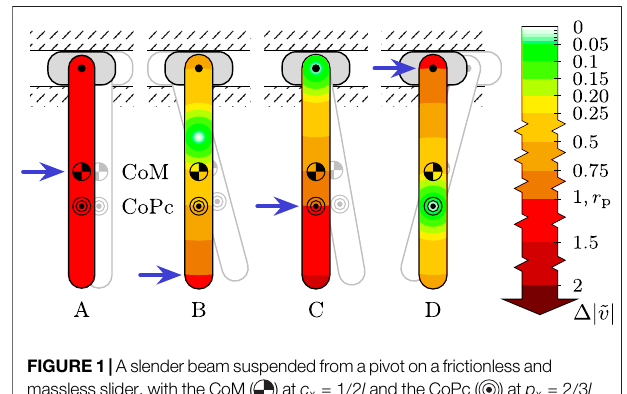
FIGURE1| Aslenderbeamsuspendedfromapivotonafrictionlessand massless slider, with the CoM ( ) at c x (cid:2) 1 / 2 l and the CoPc ( ) at p x (cid:2) 2 / 3 l from the pivot point. The initial response is shown in gray: if struck by an impactattheCoPc(beamC),thennoinitiallineardisplacementoccursat the pivot, and the other way round (beam D). The color map shows the normalized absolute shock Δ | ~ v | experienced at every point in the